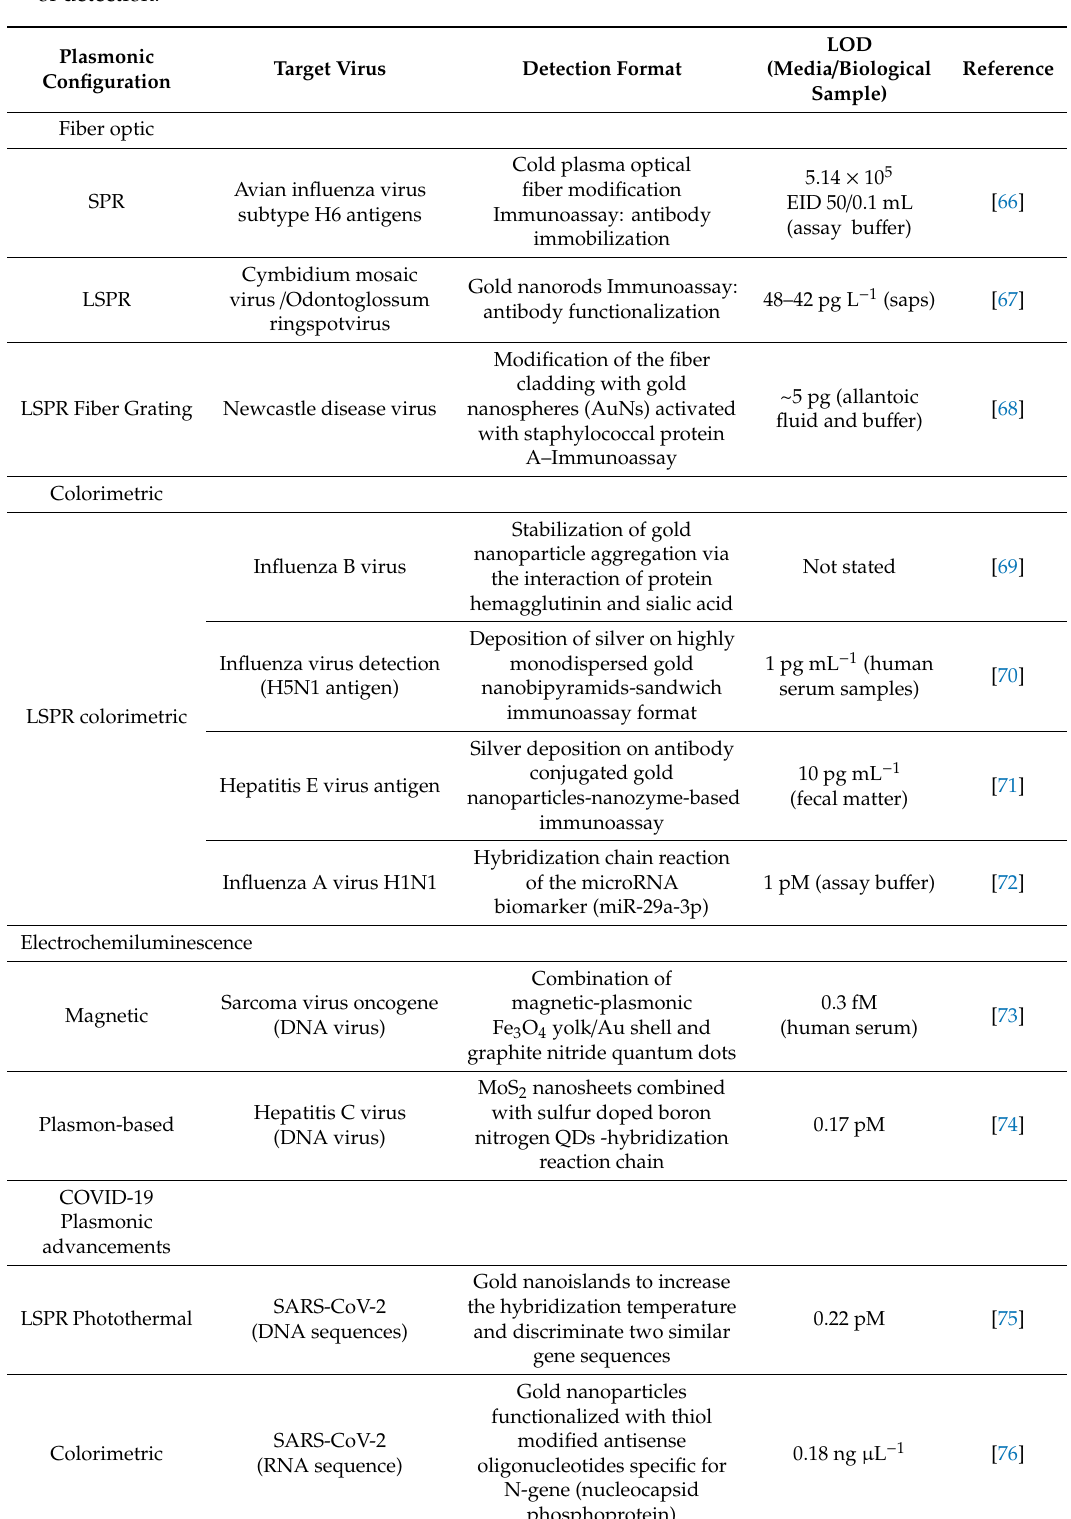
Table 2. Key analytical features of other biosensing strategies classified according to the characteristics of target virus, detection format (namely immobilization strategy or biological receptor), and limit of